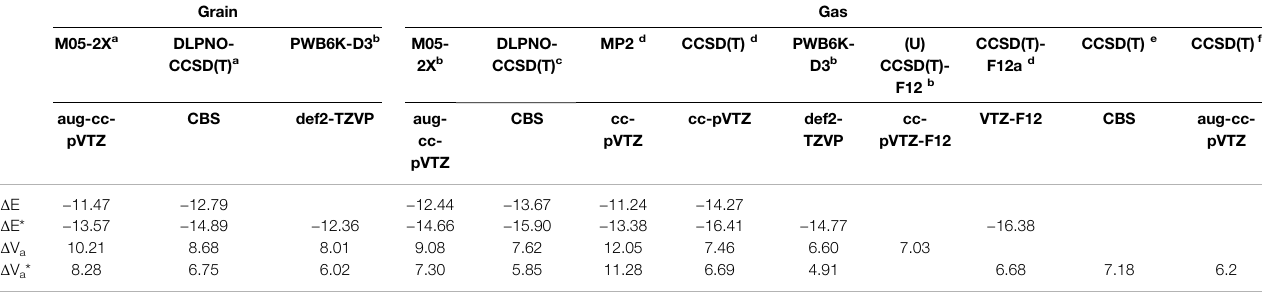
TABLE 1 | Calculated exothermicity and barrier height compared to gas phase results (kcal/mol). The inclusion of ZPE is denoted by a star symbol.